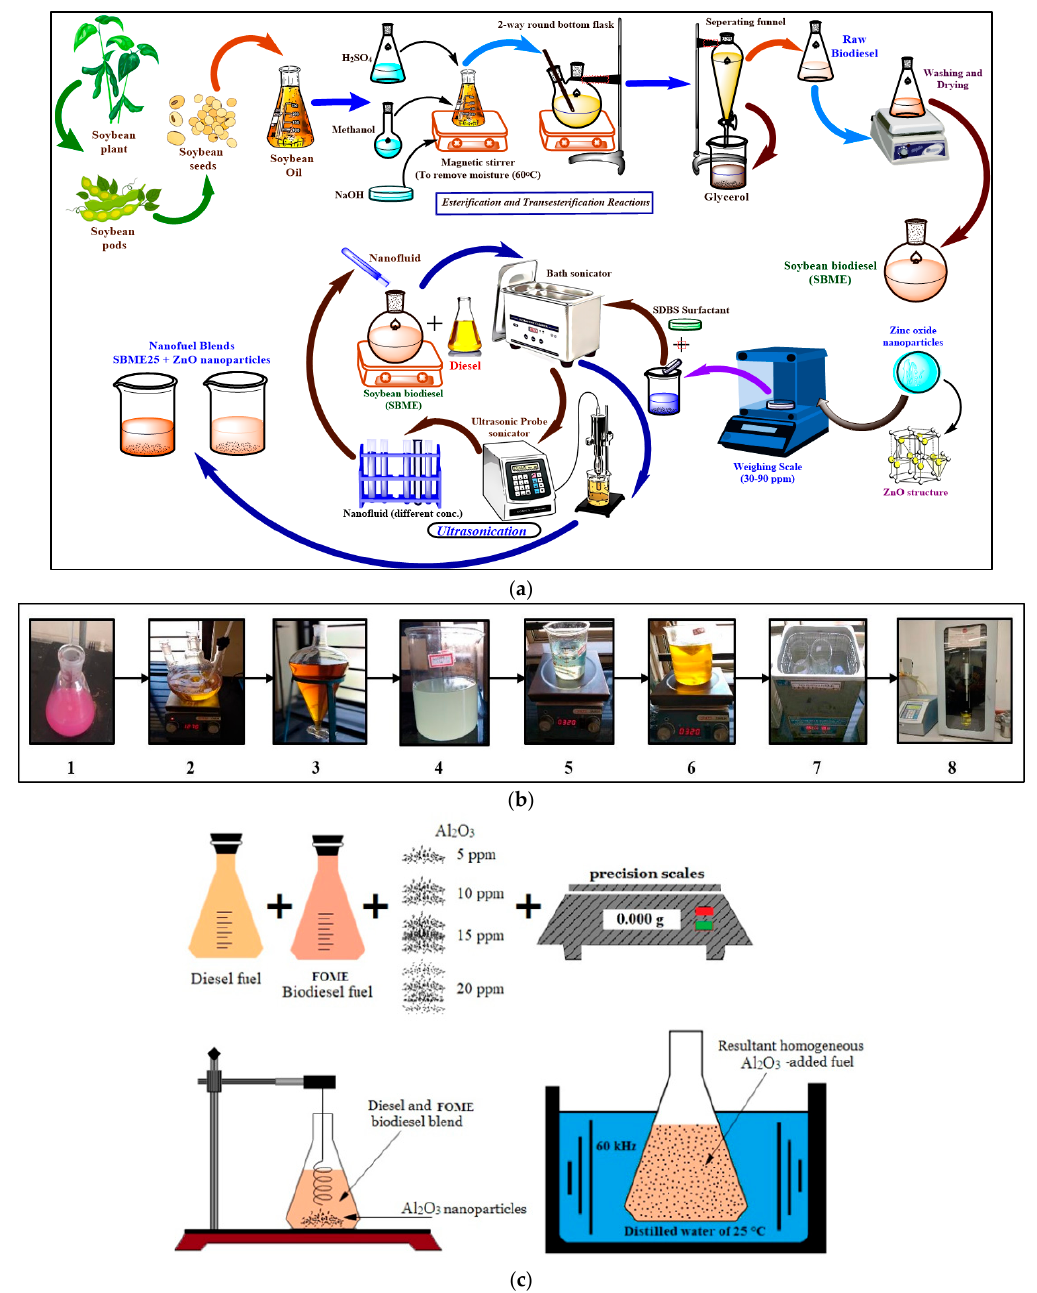
Figure 6. ( a ) Preparation of nano-fuel blends [37], ( b ) stepwise preparation of nano-fuel blends [38], and ( c ) FOME–Aluminum oxide nano-fuel preparation steps [36].